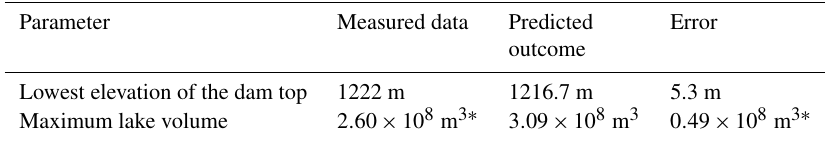
Figure 8. Comparison of the area with elevations below 2944m in the DEM to the actual submerged area in the remote sensing image (the image is from the Beijing-1 satellite). Table 2. Comparison between the predicted outcome and the measured data from a field survey (Zhou et al., 2015; Luo et al., 2019). ∗ As proper treatment has been carried out at the Hongshiyan landslide dam, this data is calculated based on a detailed field